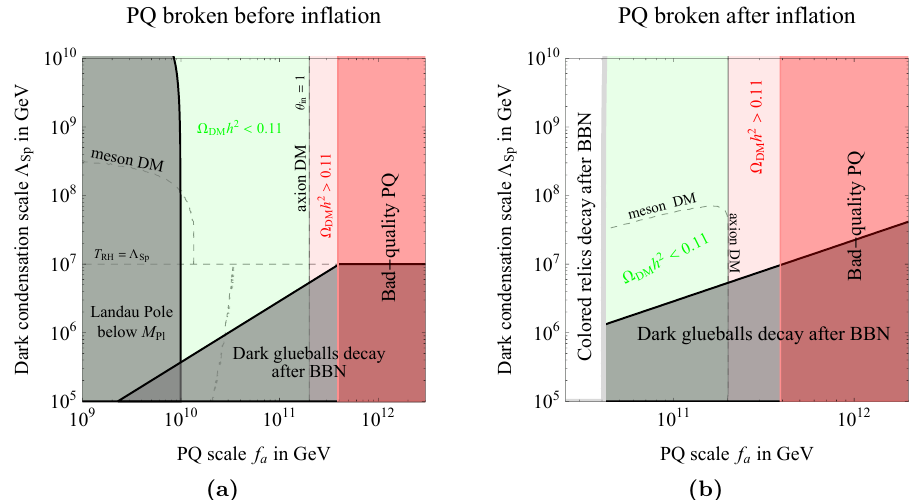
Figure 3 . Parameter space of the SU(26) model assuming Y L = 0 , Y Q = − 1 / 3 , and y Q = 1 . We chose a large N such that the cosmological DM abundance is reproduced along the red/green boundary (the dashed curve shows how this boundary would change if, in addition to the axion, a cosmologically stable LL meson with y L = 10 − 3 contributes to DM; otherwise the same plots apply for any y L (cid:28) y Q ). The right red region is disfavoured by the PQ quality arguments in eq. (3.13). Left : assuming that the PQ symmetry is broken before inflation with T RH = 10 7 GeV (cid:28) f a . The left gray region is excluded by sub-Planckian Landau poles. Right : assuming that T RH & f a , i.e. PQ-breaking after inflation. The left white region is excluded because colored relics decay after BBN ( τ Q > 0 . 1 sec